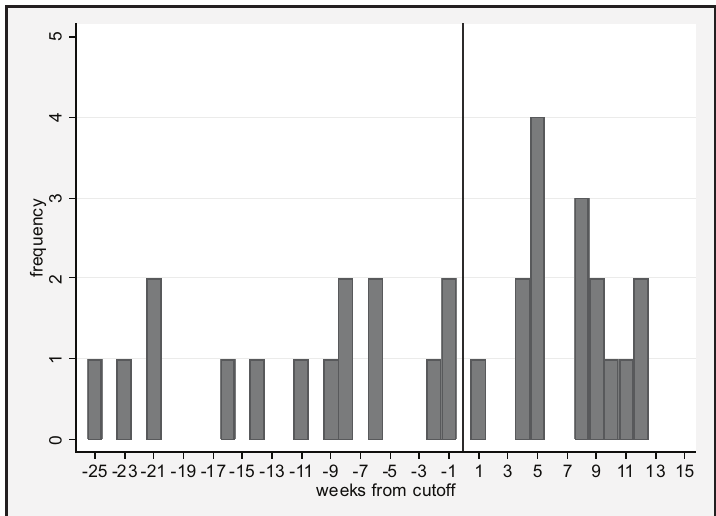
The number of collective agreements over